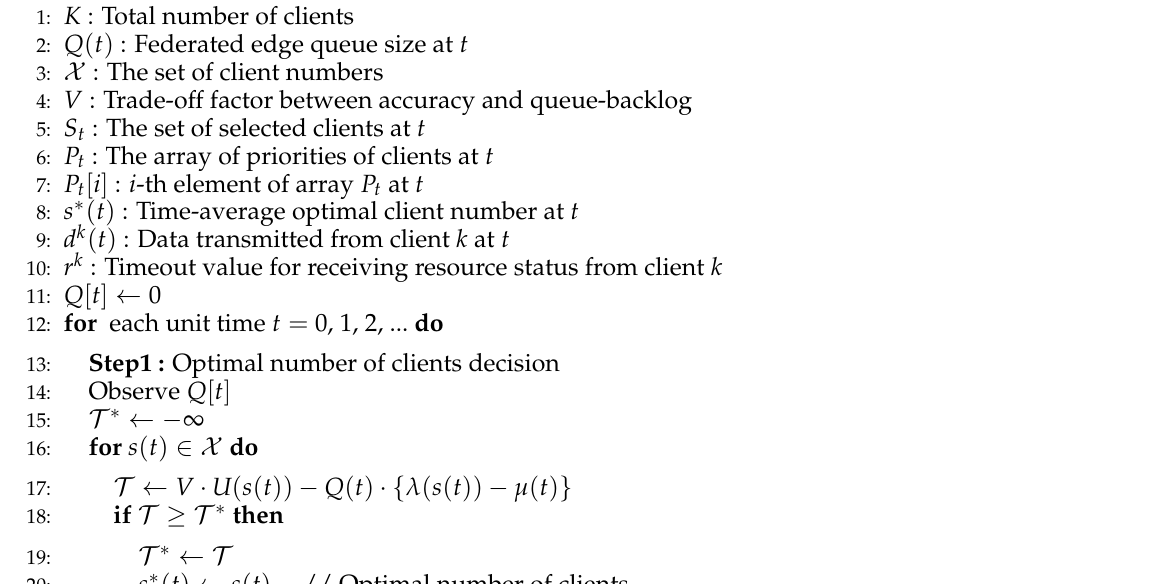
Algorithm 1 Procedure at the federated